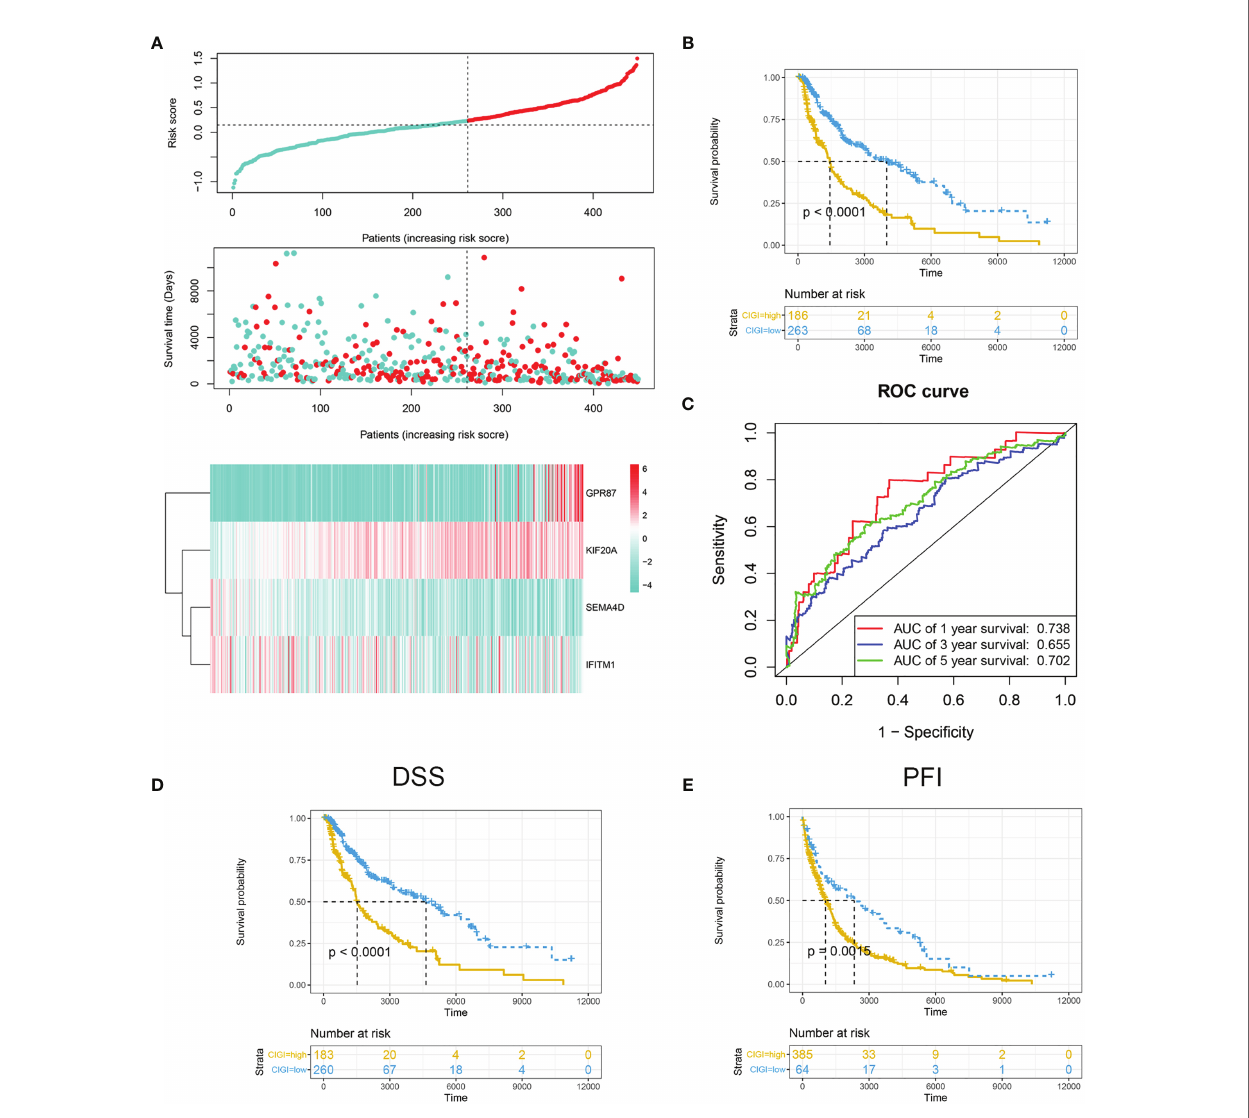
FIGURE 2 | Prognostic analysis of CIGI in the TCGA dataset. (A) Risk scores, survival times, survival status and expressions of the four genes in CIGI. (B) Kaplan – Meier analysis of the OS in the high- versus low-CIGI groups. (C) Time-dependent ROC analysis of CIGI for OS and survival status. (D) Kaplan – Meier analysis of the DSS in the high- versus low-CIGI group. (E) Kaplan – Meier analysis of the PFI in the high- versus low-CIGI